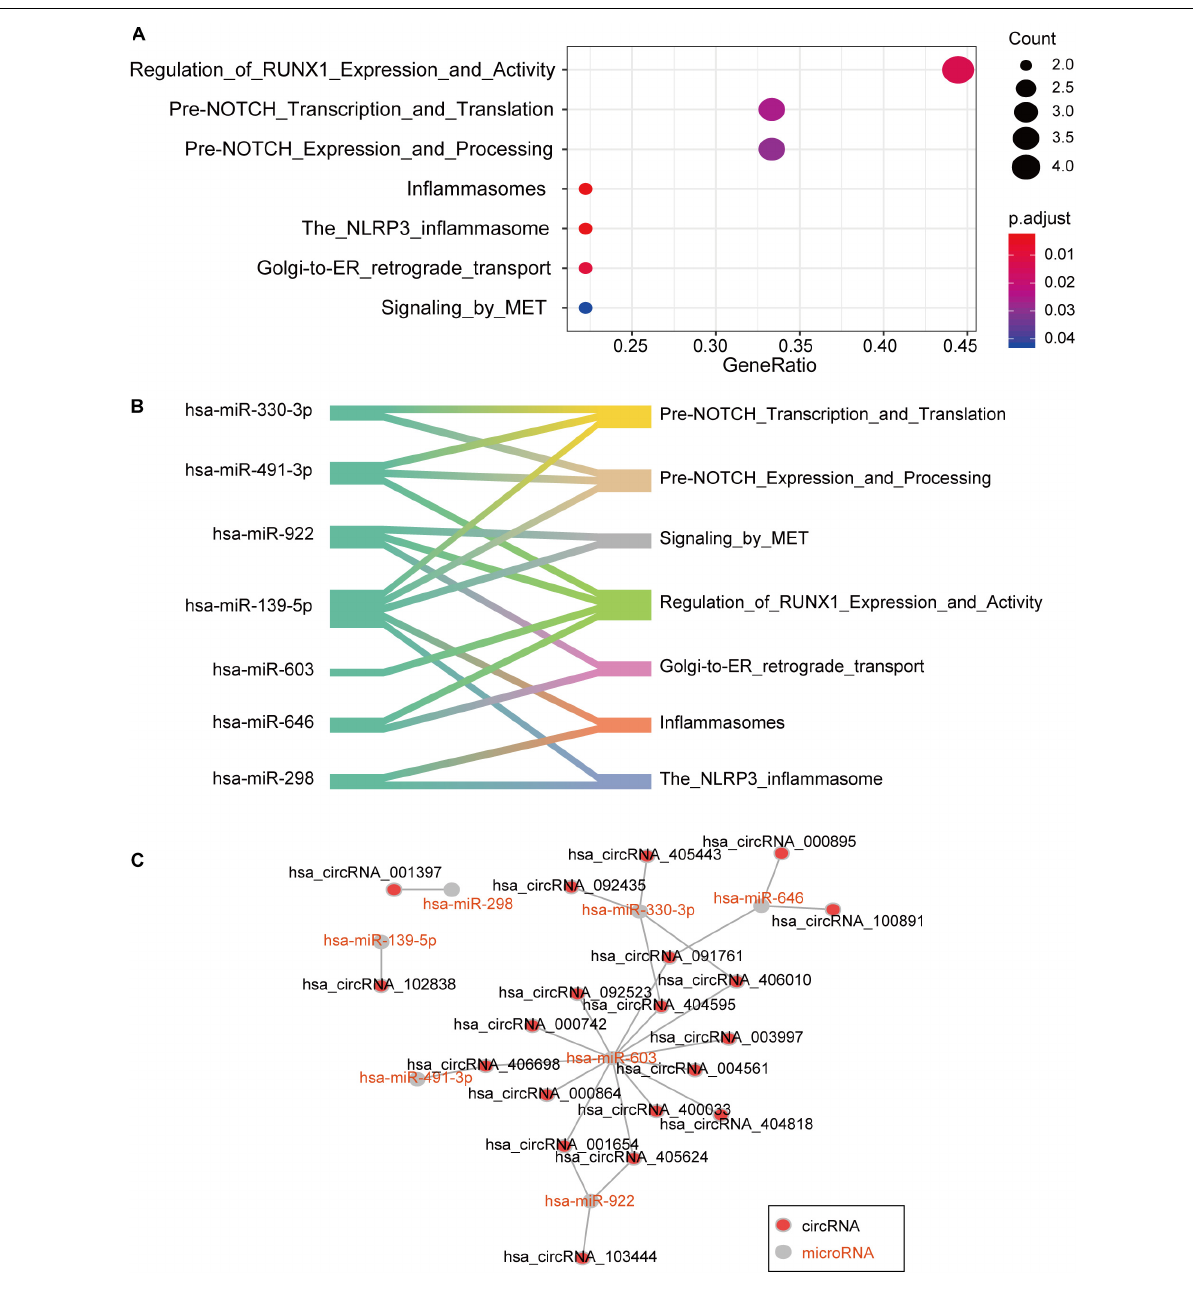
Frontiers in Genetics |